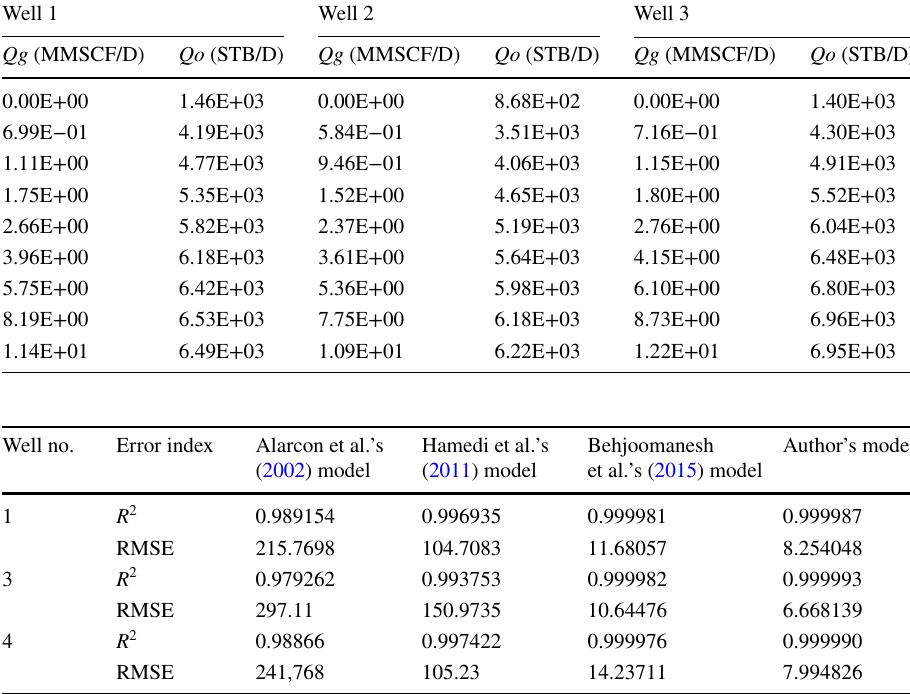
Table 6 Data of oil production versus gas injection in wells of the field